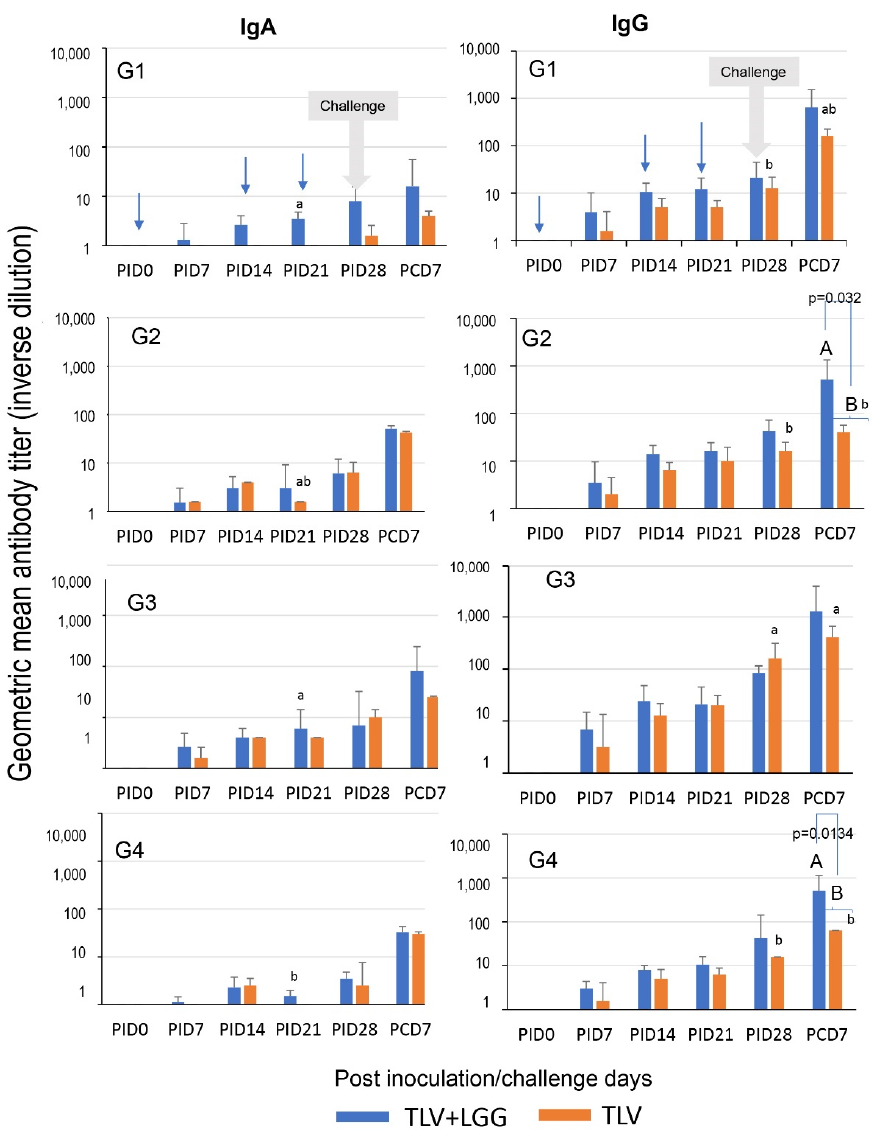
Figure 7. VP7 G-type specific IgA ( left panel) and IgG ( right panel) antibody responses detected by immunocytochemical staining assay in serum of Gn pigs vaccinated with TLV with or without LGG. Bars with different uppercase letters (A, B) indicate a statistical difference between treatment groups (repeated measure ANOVA-GLM, p < 0.05). Bars with different lowercase letters (a, b) indicate significant differences among VP7 G-type specific antibody responses within each vaccine in the selected timepoint (one-way ANOVA, p < 0.05). Blue arrows indicate the immunization times (3 × ) and grey arrows the challenge time with virulent Wa HRV G1P[8] strain.